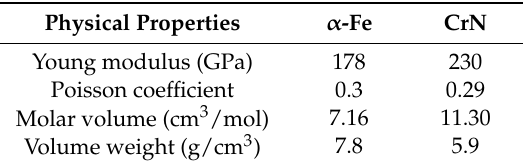
Table 2. Physical properties of ferrite (bcc-iron) and chromium nitride (fcc-CrN) used as input for the mechanical calculations.